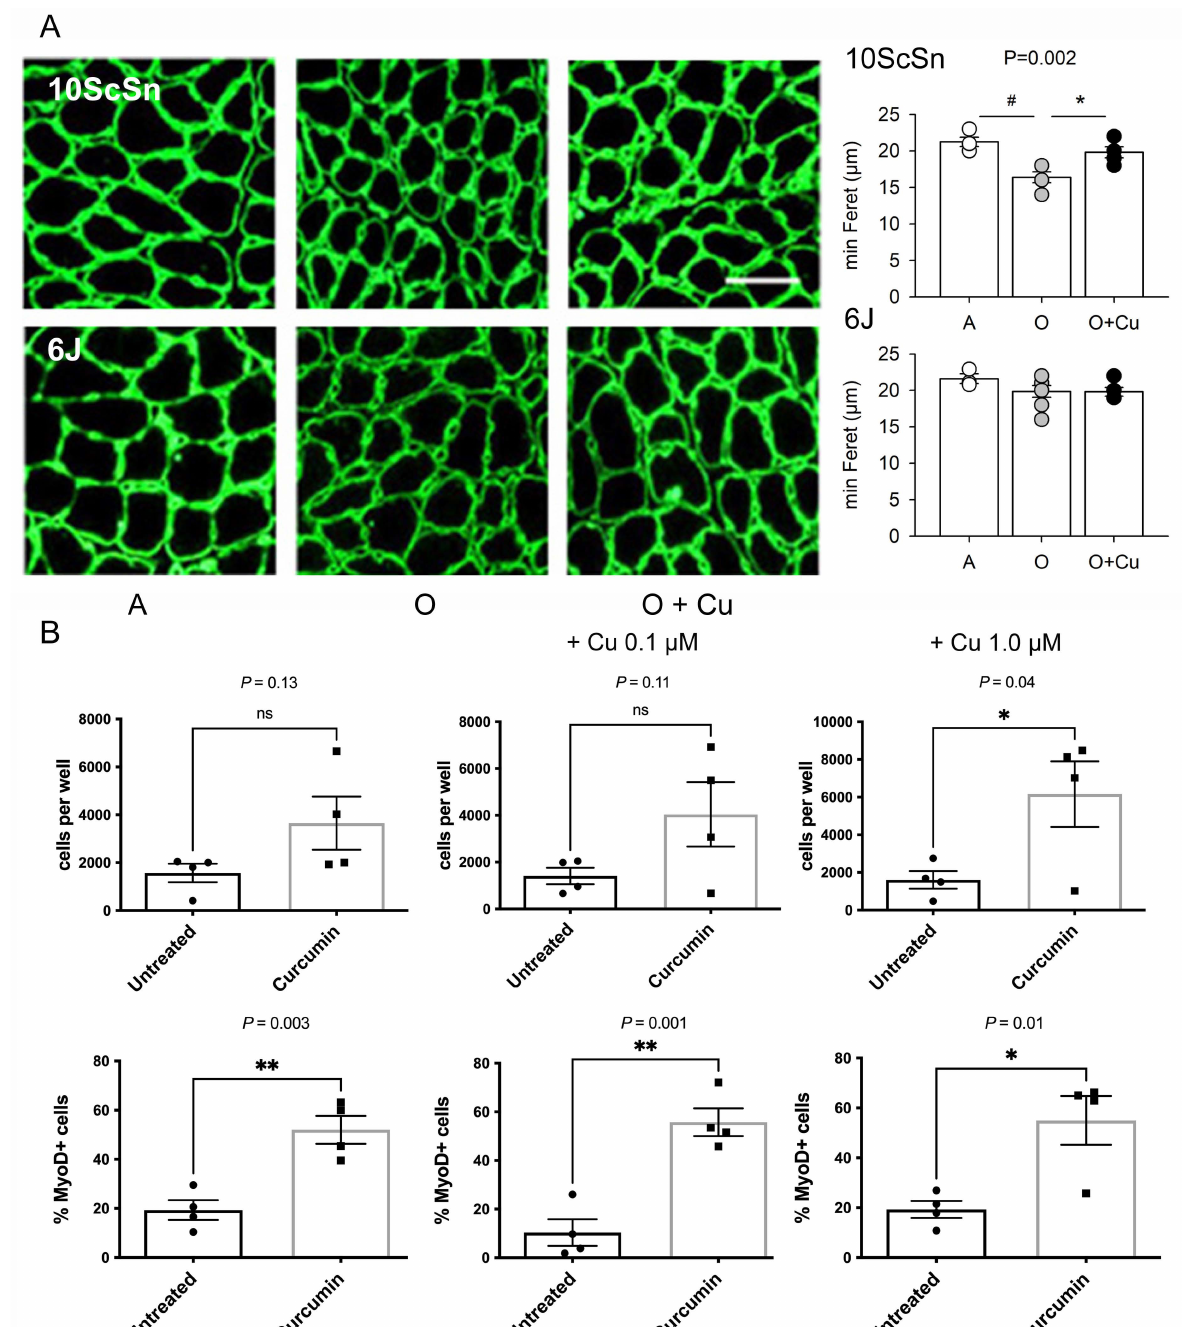
Figure 6. ( A ) Left panels: Representative laminin immunofluorescence of 10-day regenerated soleus myofibers from Adult (A), vehicle-treated old (O) and curcumin-treated old (O + Cu) mice from 10ScSn (top row) and 6J strains (bottom row). Bar: 50 µ m. Right panels: Histograms of mean and SEM values of minimal Feret diameter evaluated on at least 400 fibers/muscle from A (n = 4), O (n = 5) and O + Cu (n = 6) 10ScSn soleus muscles and A (n = 3), O (n = 7) and O + Cu (n = 5) 6J ones. Statistical significant difference (ANOVA p < 0.002) is indicated by # between A and O (p < 0.002), and by * between O and O + Cu ( p < 0.007). ( B ) Quantification of CD45-/CD31-/Sca1- cells, prepared from hindlimb muscles of curcumin- and vehicle-treated mice, found after 8 days culture in each 0.8 cm 2 well; 3K cells per well were initially plated at day zero. Top row: total cells, identified by DAPI staining. Bottom row: percentage of MyoD+ cells, identified by immunofluorescence, in the same preps. Statistical significance was calculated using unpaired Student’s t -test. Only preps that provided enough cells for MyoD staining are